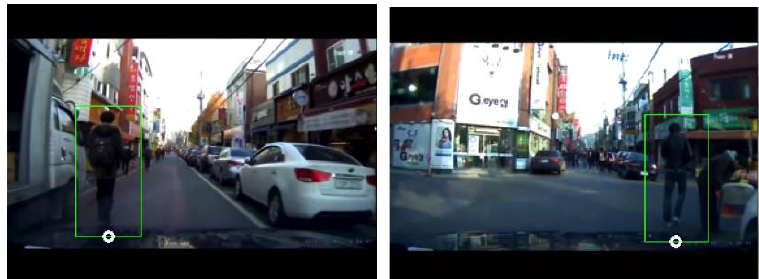
Figure 3. Detection of pedestrian using the histogram of gradient (HOG) + support vector machine (SVM) method. The pedestrian detected is marked with a green box bounding the pedestrian. The midpoint of the base of this box is used as the pedestrian’s position in the image.